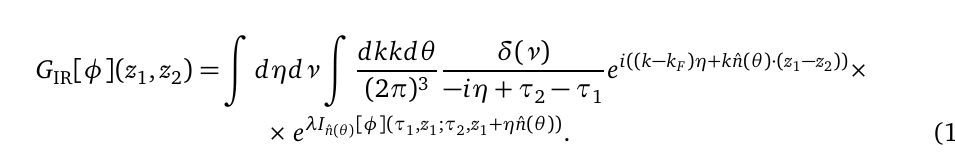
Figure 1: The green areas indicate the regions in momentum space where the approximate background-field Green’s functions G the gray area is the Fermi